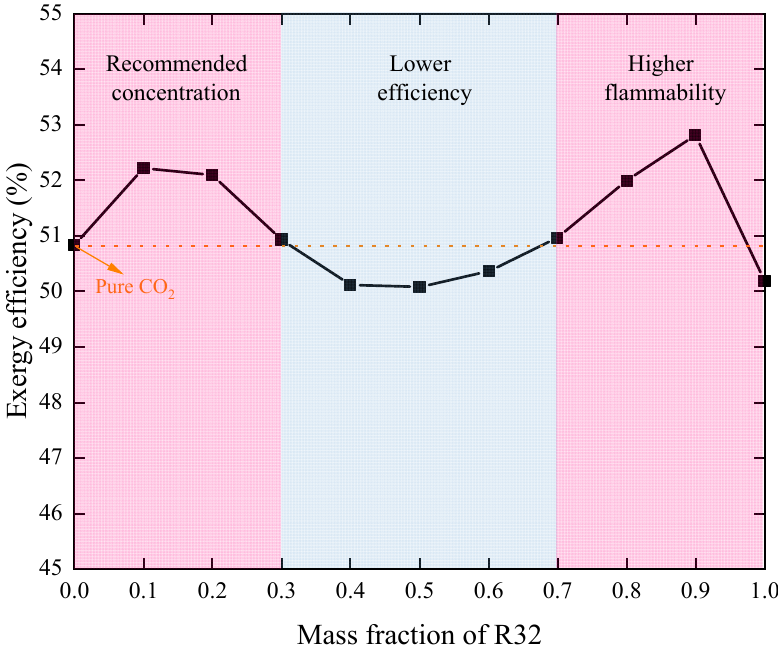
Figure 7. The exergy efficiency with the range of R32 mass fractions. Therefore, based on the results discussed above, an R32 mass fraction of 0.1 to 0.3 is recommended, and the optimal mass fraction of the CO 2 /R32 mixture is 0.9/0.1. A comparison of the temperature-entropy diagram at the optimal system COP and